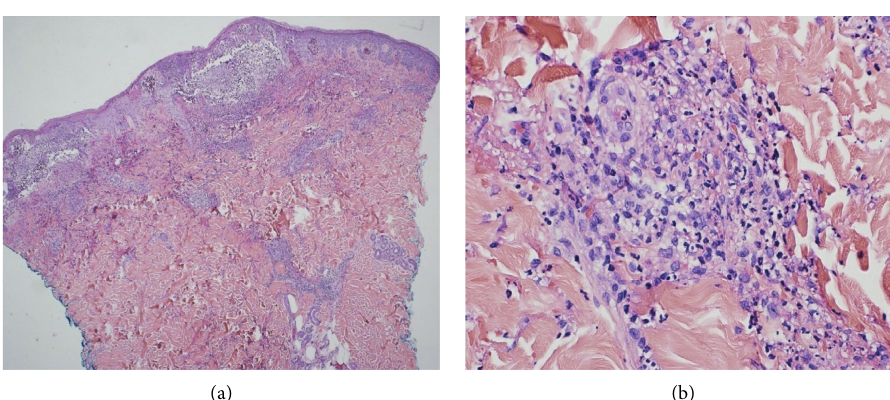
Figure 1: A punch biopsy of skin involved by a brisk acute small vessel neutrophilic vasculitis that extends from the papillary to midreticular dermis. There is prominent associated fibrinoid necrosis of vessel wall, leukocytoclasis, purpura, and epidermal degeneration. Original magnification: 4X in (a) and 40X in